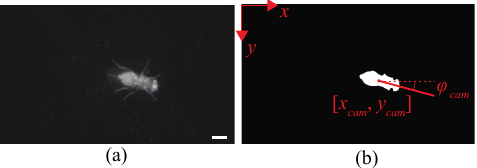
Figure 3. ( a ) An example of a captured NIR image of a walking fruit fly using the illumination system. The scale bar is 1 mm. ( b ) binarized image of the image in ( a ). The configuration of a walking fruit fly on the image p cam = [ x cam , y cam , ϕ cam ], which are the position in the x - and y -axis (red dot), and the orientation with respect to the x -axis (red line). The origin of the image coordinate is located on the left top corner. The pixel distance of a NIR image is 25.7 μ m/pixel.